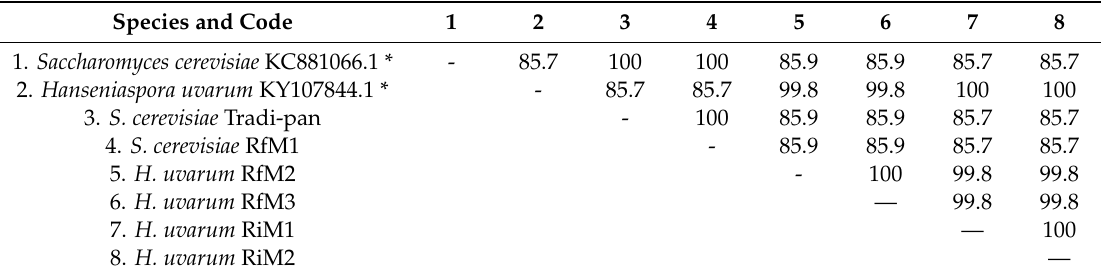
Table 2. Comparison of percentage similarity of PCR-amplified 26S nucleotide sequences of the yeasts isolated in this study and the corresponding type